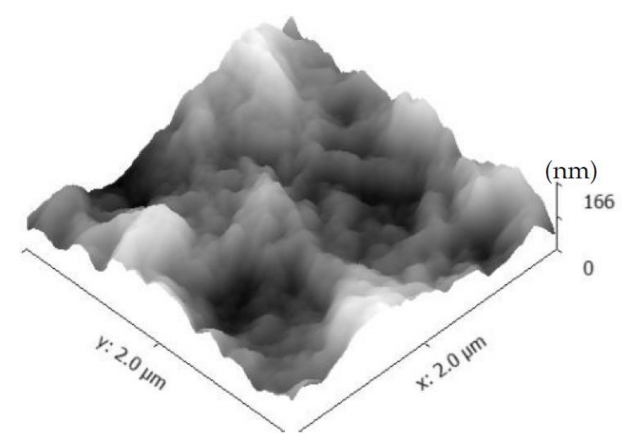
Figure 13. AFM image of PEI/PSS-CSH-GO showing the wavy morphology with increased roughness compared to that of PEI/PSS-CSH without GO nanosheets, as shown in Table